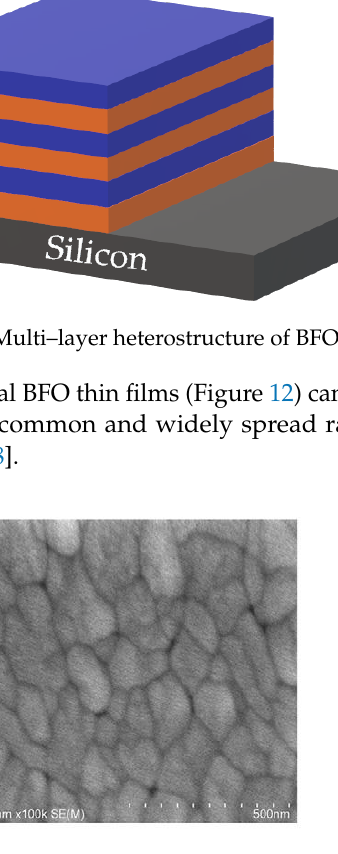
Figure 10. Strain coefficient dependence on thickness [28].